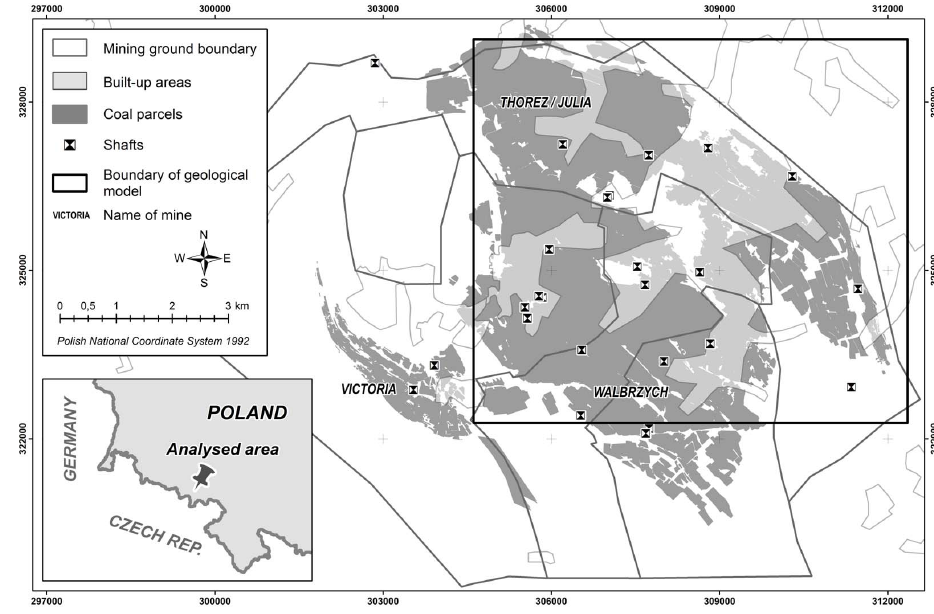
Figure 2. Location of the former Walbrzych coal mines (Blachowski and Milczarek, 2011).